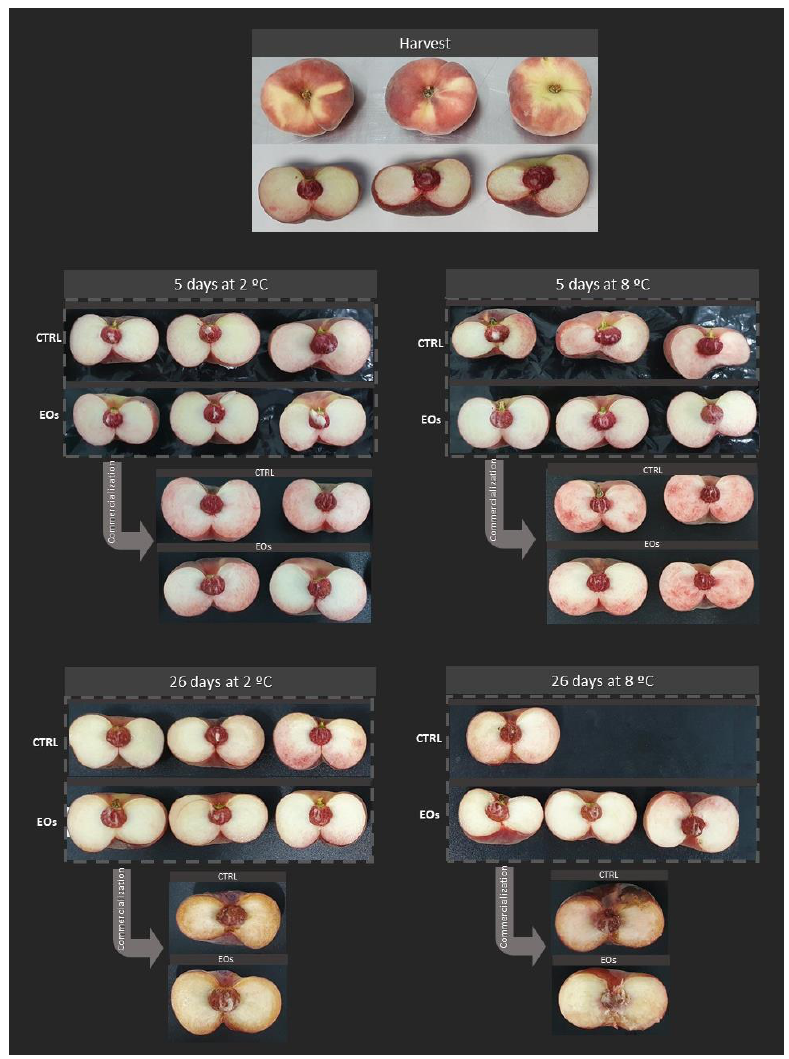
Figure 4. Flat peaches during cold storage periods (2 and 8 ◦ C) and complimentary commercialization simulations (COM; 4 days at 22 ◦ C) without (CTRL) or with active paper sheets (EOs) ( n = 3 ± SD).